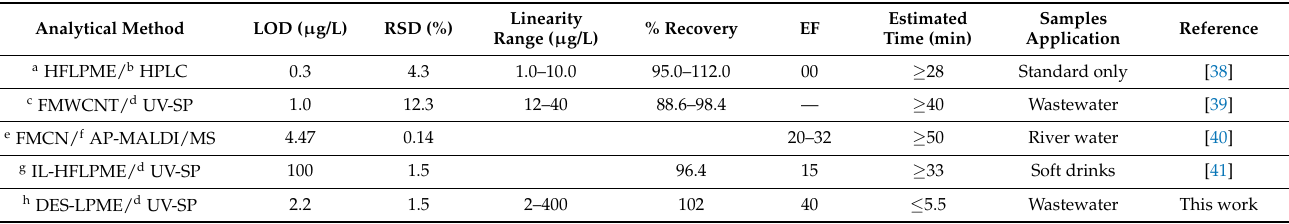
Table 2. Comparison of analytical methods and parameters for